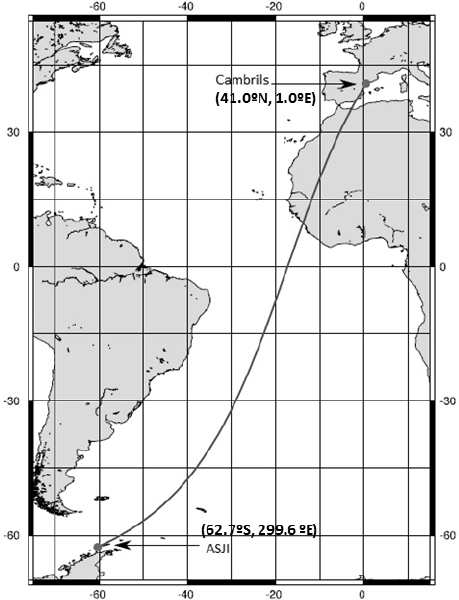
Figure 1. Geographical link characteristics. The transmitter is located at the Antarctic Spanish station Juan Carlos I (ASJI), on Livingston Island (62.7 ◦ S, 299.6 ◦ E), and the receiver is placed in Cambrils (41.0 ◦ N, 1.0 ◦